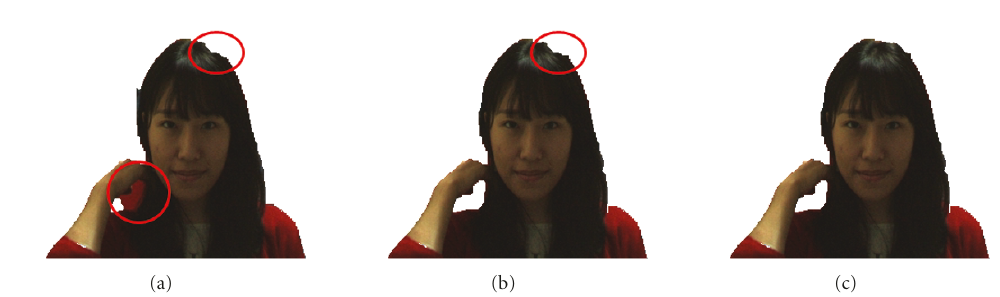
Figure 12: Segmentation results of the proposed algorithm I on the “Woman in Red” sequence: (a) sensitivity term only, (b) sensitivity and color terms, and (c) sensitivity, color, and temporal coherence terms.